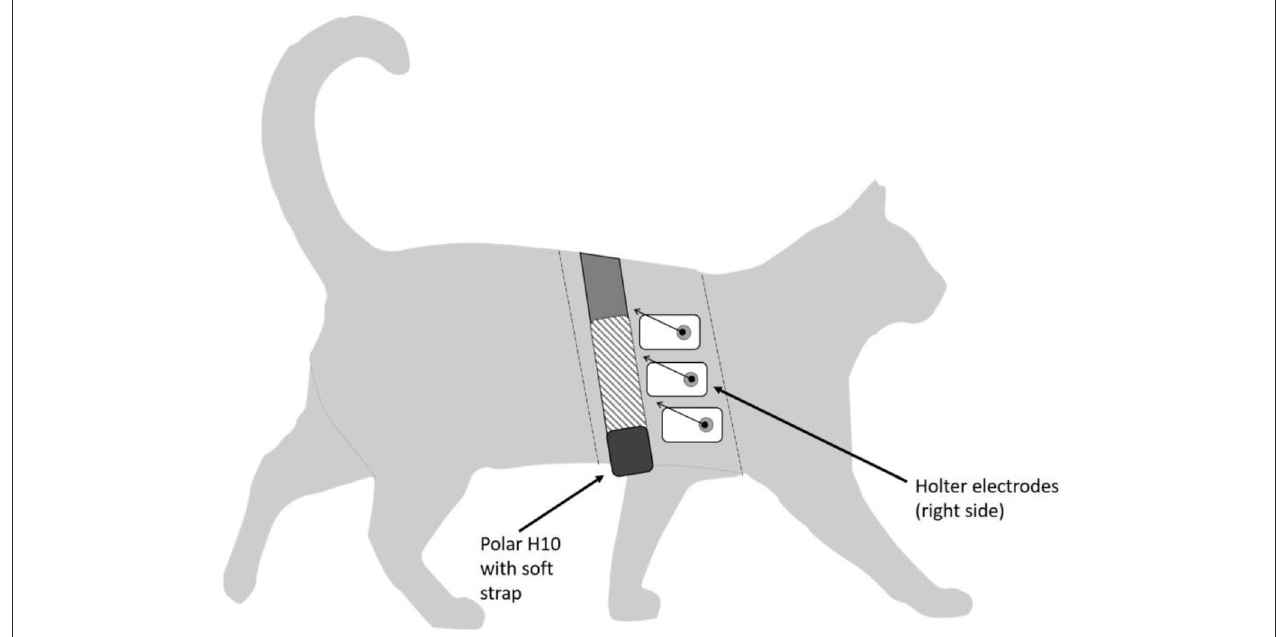
FIGURE 1 | Diagram of study cat, showing placement of Holter electrodes and Polar H10 sensor with elastic strap. Dashed lines represent approximate cranial and caudal edges of the shaved area. Polar electrodes are located within the soft strap (shown as hatched area of strap). Leads on the Holter electrodes are shown as abbreviated arrows for image